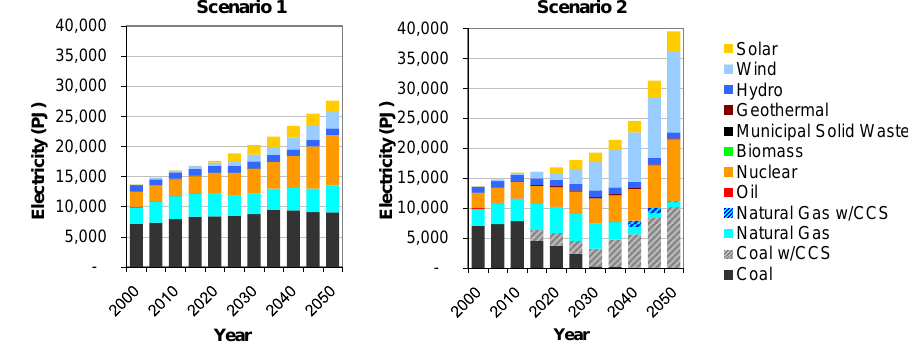
Fig. 3. Production of electricity by technology for Scenarios 1 and 2. Formatted for color reproduction only.